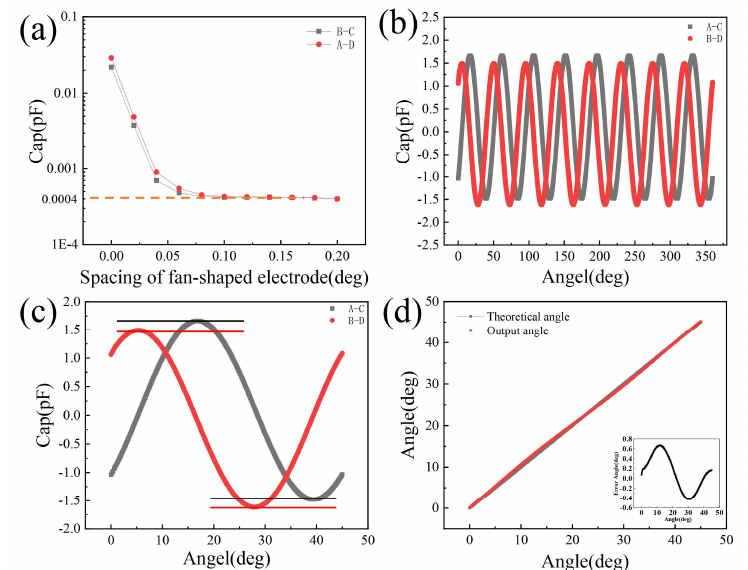
Figure 6. COMSOL simulation data results: ( a ) the initial capacitance difference; ( b ) curves of C A –C C and C B –C D ; ( c ) a single cycle of 2π/X (45°) from Figure 6b and the difference; and ( d ) the calculation angle and the theoretical angle, the error in the illustration.